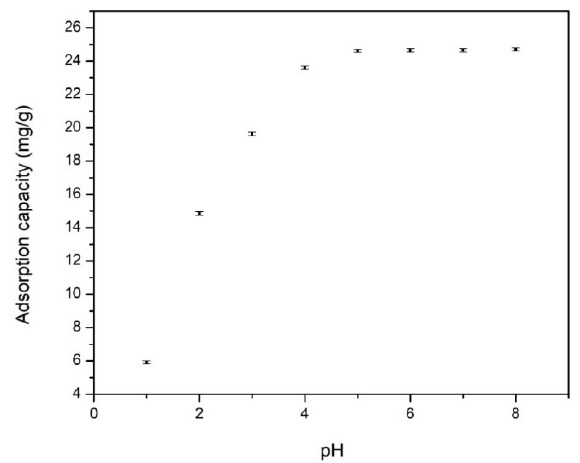
Figure 4. pH effect on adsorption capacity of Cd on functionalized chitosan.